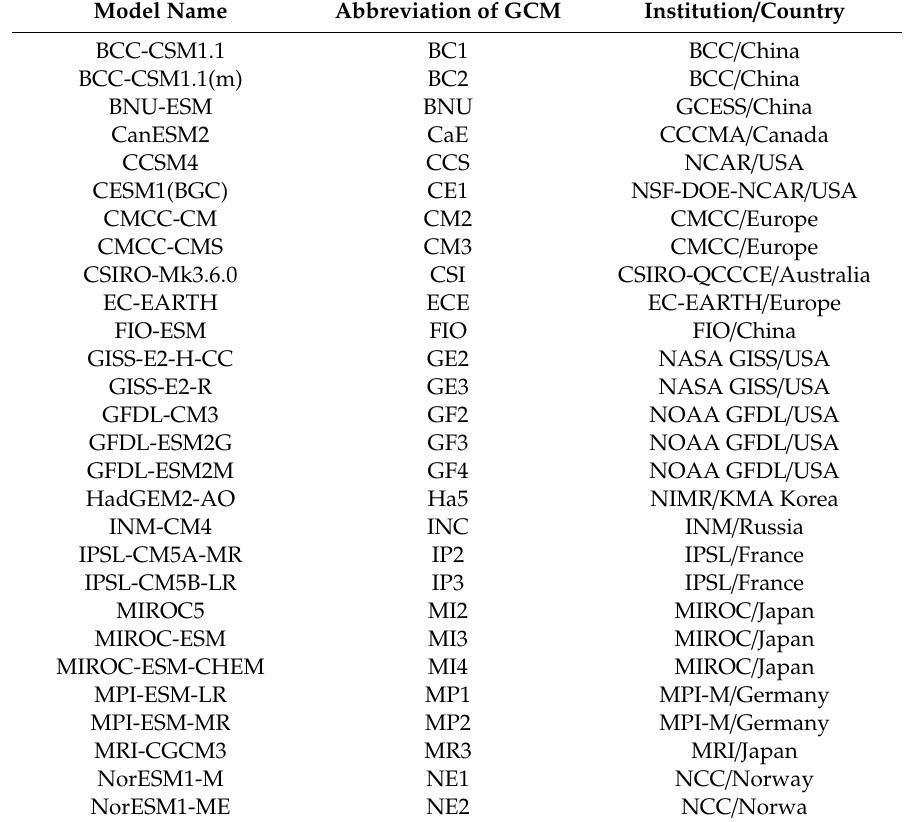
Table 1. Information on the 28 CMIP5 models used in the